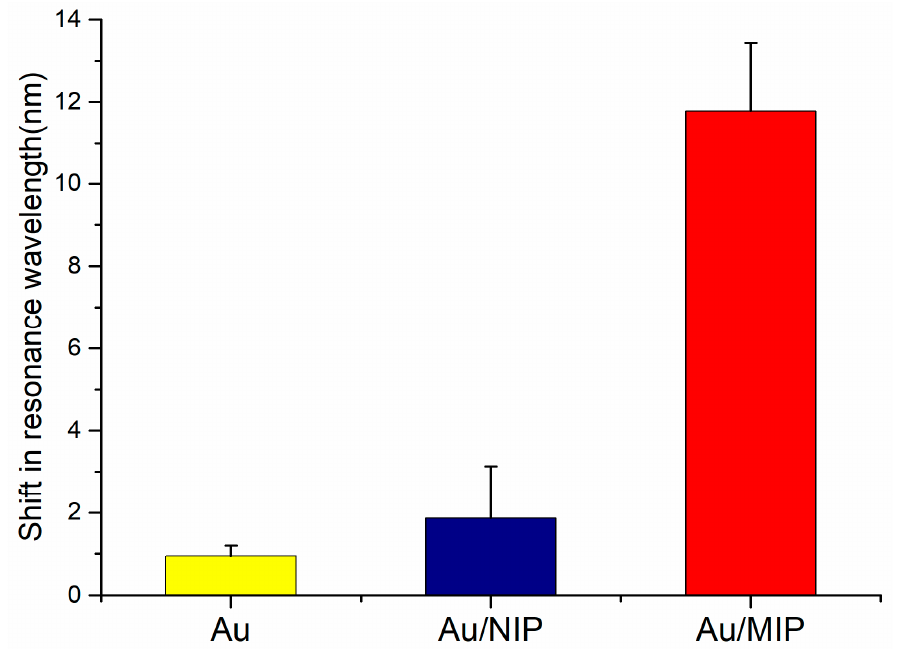
Figure 7. Recognition ability of PoAP–MEL film. Resonance wavelength shift for the detection of melamine solution with concentration ranging from 0 M to 10 − 7 M.